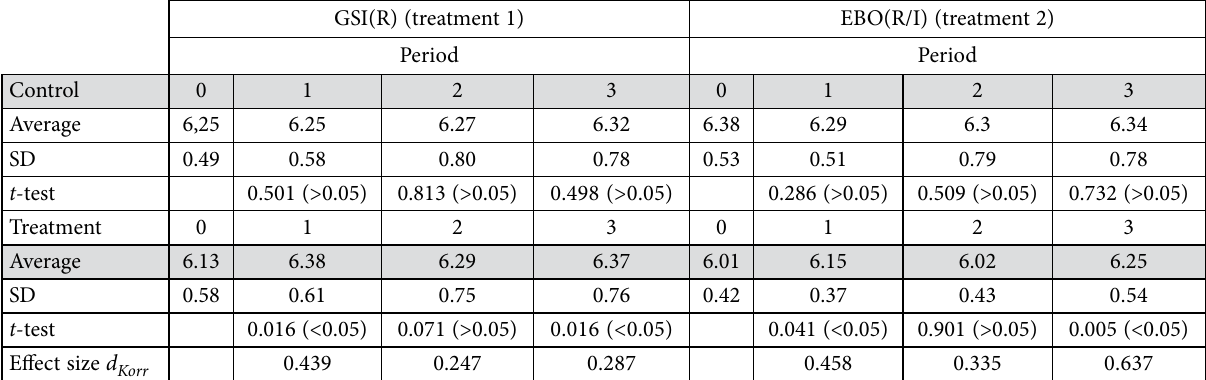
Table 3. Distance travelled in km with one gallon of fuel (months 1…3)